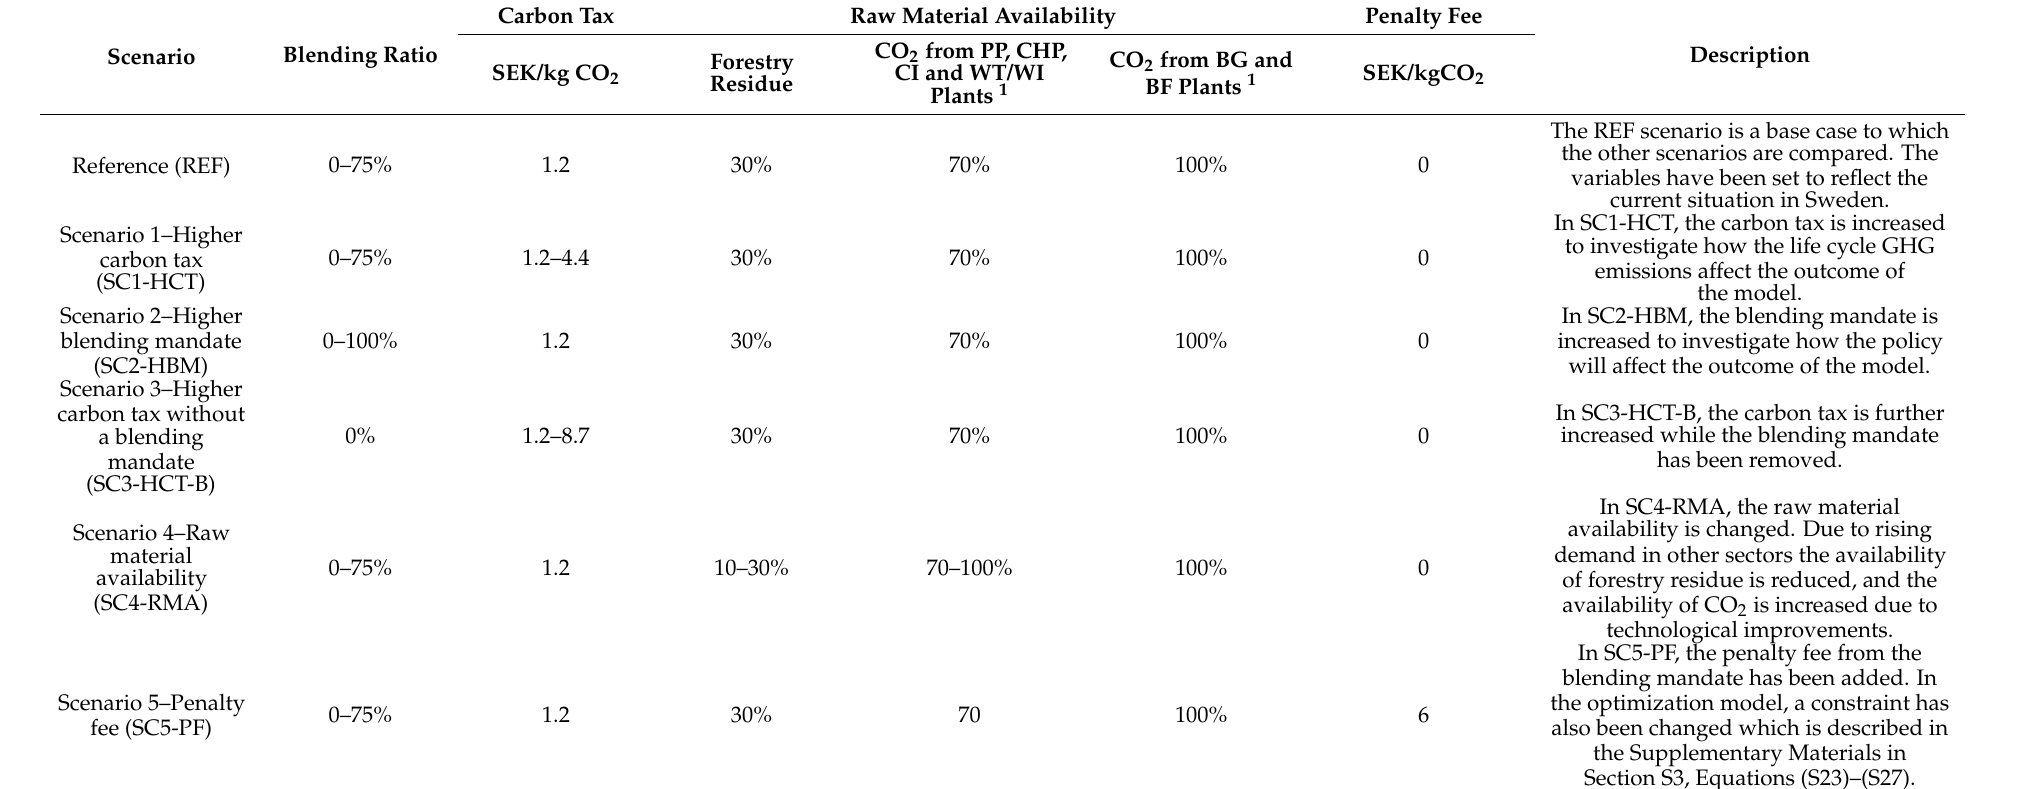
Table 9. Summary of scenarios development and key parameters altered in each